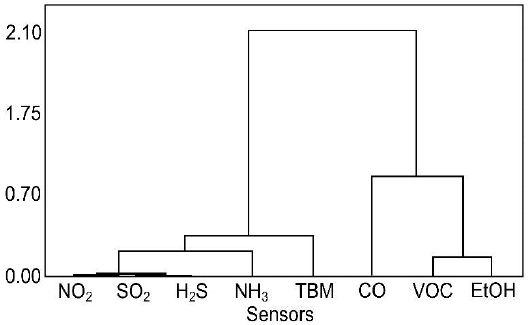
Figure 7. Cluster analysis of variables (sensors) during poultry shelf-life evaluation.